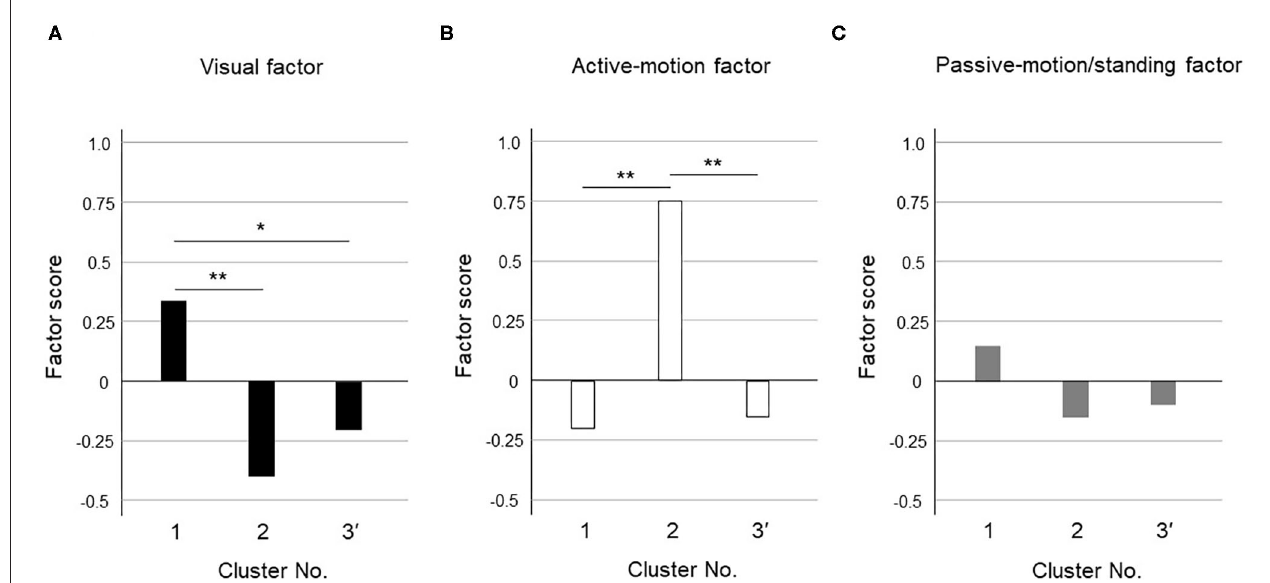
FIGURE 3 | Cluster differences assessed using the variance analysis by Tukey method for three clusters. The factor scores were shown in each cluster for (A) Visual factor, (B) Active-motion factor, and (C) Passive-motion/standing factor. The cluster 1 had a high visual factor score, so we termed it the “visual-dominant subtype.” The cluster 2 had a high active-motion factor score, so we termed it the “active motion-dominant subtype.” The cluster 3’ had no dominant exacerbation factors but was seemed to be exacerbated equally by all three factors, which was termed the “mixed subtype”. The single asterisk (*) indicate p < 0.05 and the double asterisks (**) indicate p < 0.01 by Tukey method.